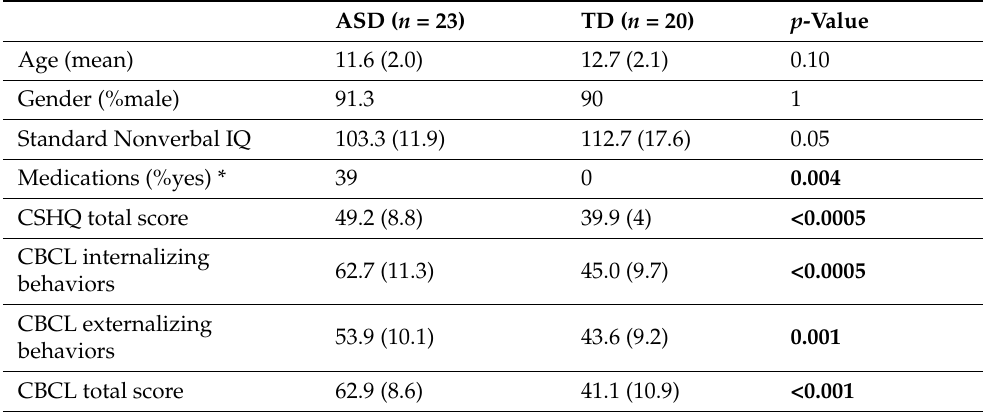
Table 1. Participant